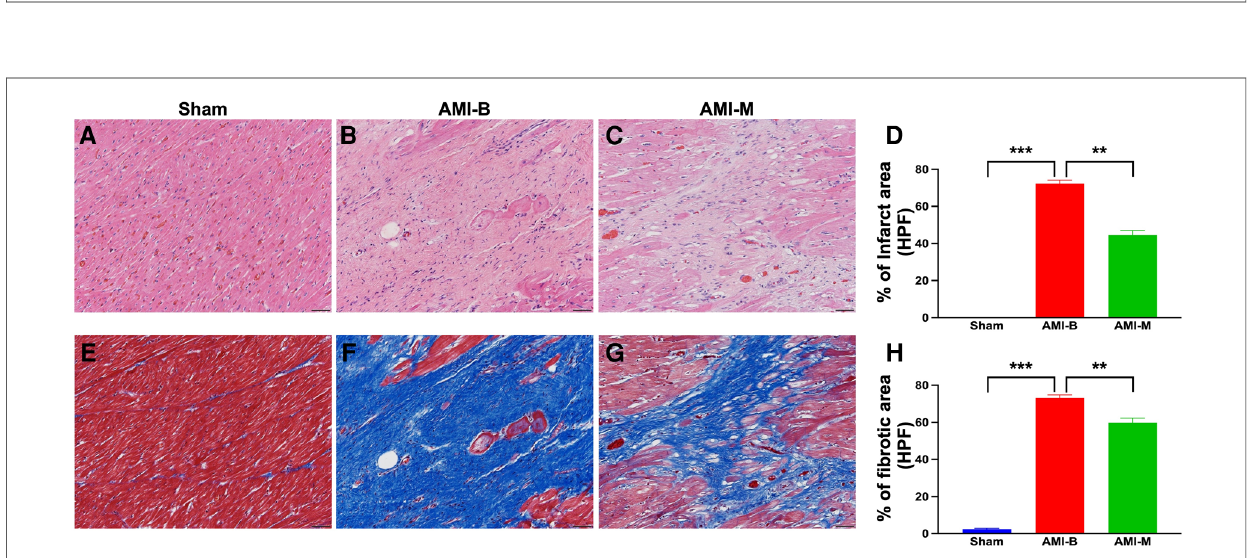
FIGURE 4 Histopathological assessment of LV myocardium 5 months after AMI induction. ( A – C ) The microscopic fi nding (200×) of H&E stain for identi fi cation of infarct area (red-white area). ( D) Analytical result of the infarct area (%)/HPF; ** p <0.001; *** p <0.00.1. ( E – G) The microscopic fi nding (200×) of Masson ’ s trichrome stain for identi fi cation of the fi brotic area (blue color). ( H) Analytical result of the fi brotic area (%)/per HPF); ** p <0.001; *** p <0.0001. All scale bars in lower right corner represent 50 µm. Sham (group 1), sham-operated control; AMI-B (group 2), AMI+buffer; AMI-M (group 3), AMI+hBMMSC; AMI, acute myocardial infarction; hBMMSCs, human bone marrow-derived mesenchymal stem cells; LV, left ventricular; HPF, high-power fi eld; H&E, hematoxylin and